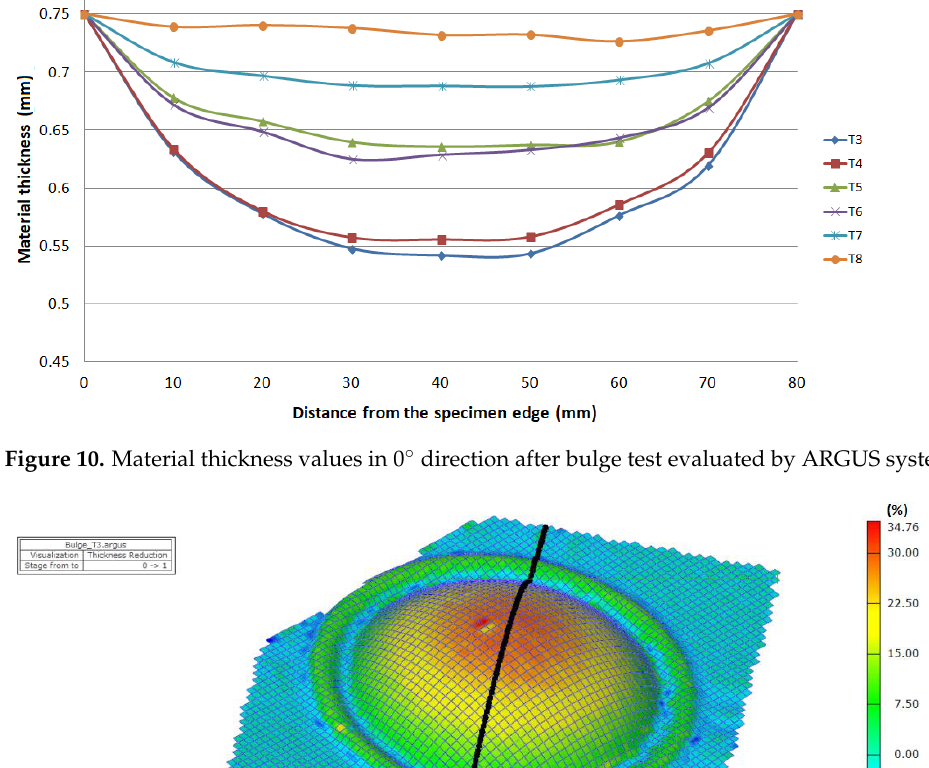
Figure 9. Material thickness values in 90° direction after bulge test.